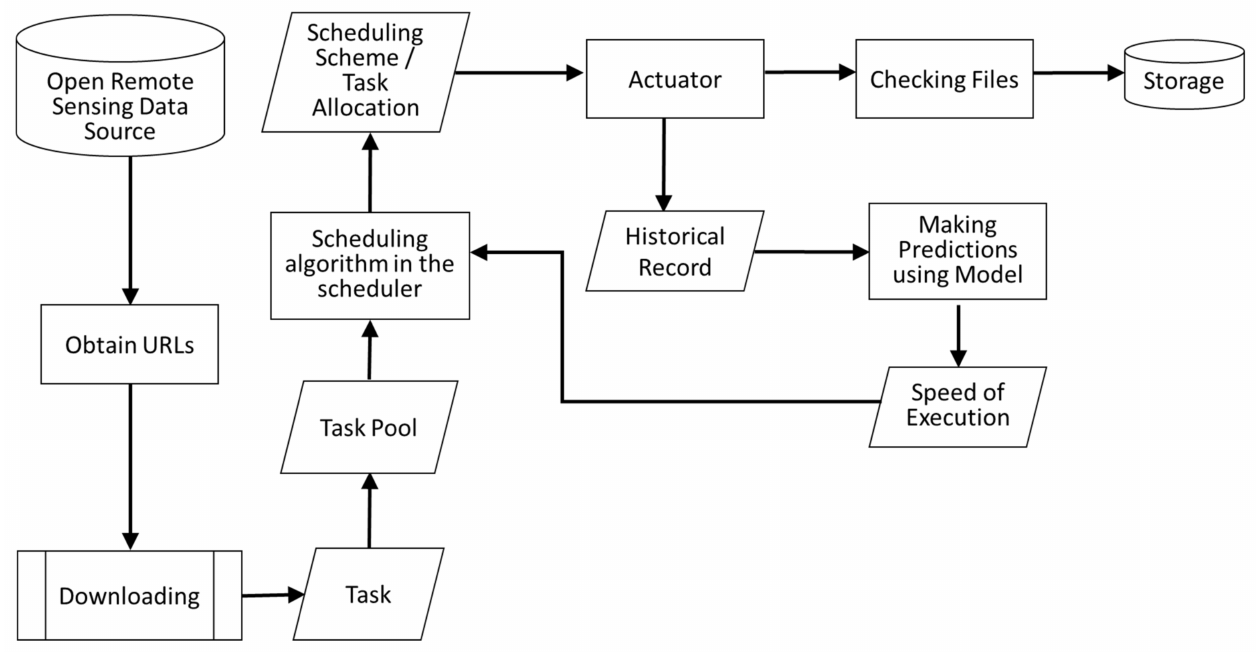
Figure 1. Task scheduling architecture